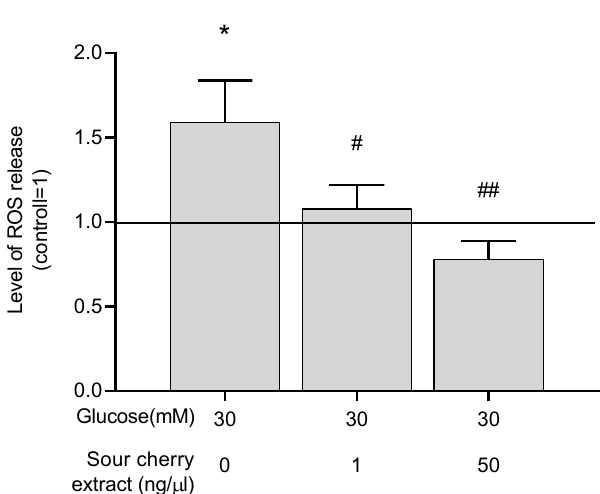
Figure 2. Anthocyanin-rich sour cherry extract decreases production of reactive oxygen species (ROS) under hyperglycemic condition. Production of ROS by HUVECs was monitored following 48 h treatment by 2 ′ ,7 ′ -dichlorofluorescin diacetate (DCFDA) staining. Results are expressed as the percentage of untreated control (100%, solid line) with normoglycemia (5 mM) as mean ± SEM of four independent determinations. * marks a statistically significant difference ( p < 0.05) compared to the vehicle control group. #, ## marks significant ( p < 0.05, p < 0.001) differences as indicated compared to the untreated control with hyperglycemia (30 mM).